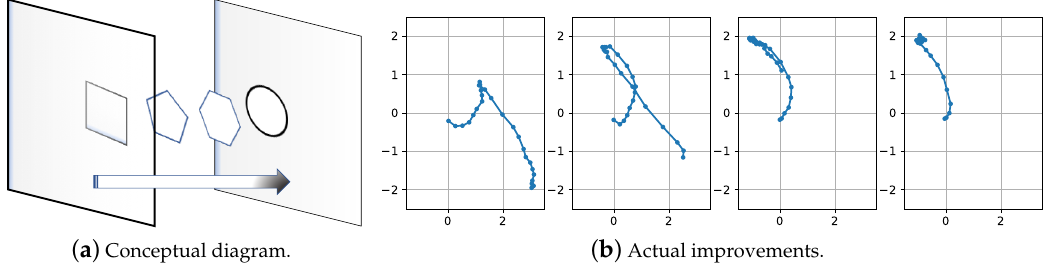
Figure 13. Conceptual diagram of the improvement of skills reflected in latent space, along with actual improvements observed for motion skill ”forehand drive” when used in a closed loop.